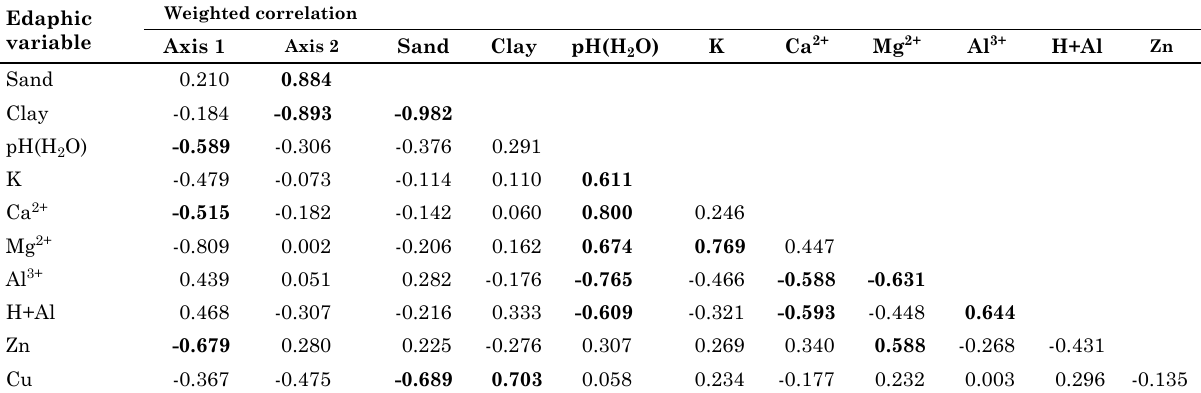
Table 4. Canonical correspondence analysis (CCA) of the abundance of 13 species sampled in 25 plots located in the municipality of Montes claros de goiás, goiás,